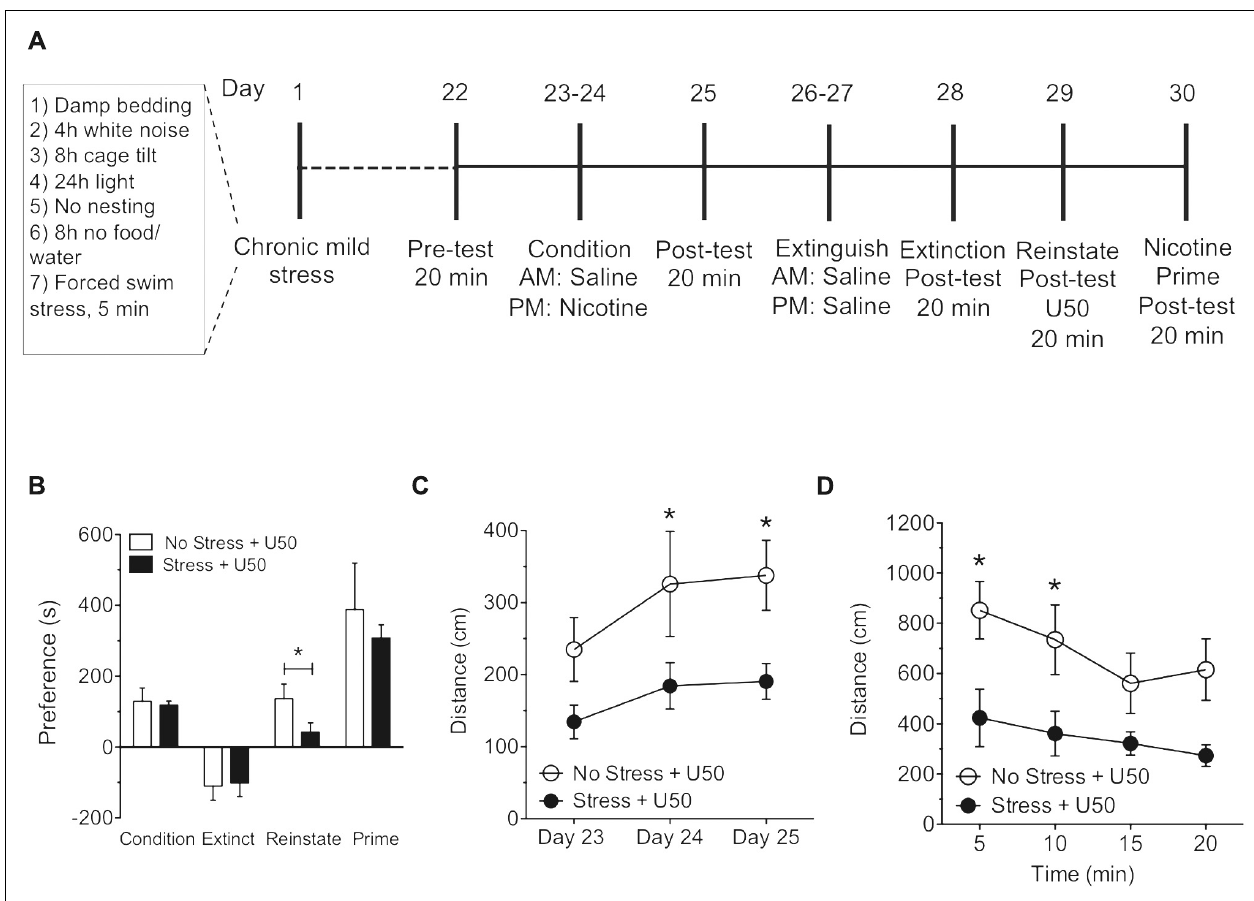
FIGURE 4 | Exposure to chronic mild stress blocks U50,488-induced but not nicotine-primed reinstatement of nicotine place preference. (A) Timeline of nicotine place preference-reinstatement experiment. (B) Nicotine preference scores (day 26), calculated as post-test minus pre-test on the nicotine-paired side(condition), U50,488-induced (5 mg/kg, i.p.; reinstate, day 31) and nicotine-induced (0.5mg/kg, i.p) reinstatement (prime, day 32) scores of extinguished place preference. Data show a significant reinstatement of nicotine place preference following U50,488 in the no stress group. Groups are defined in the figures as their final reinstatement grouping